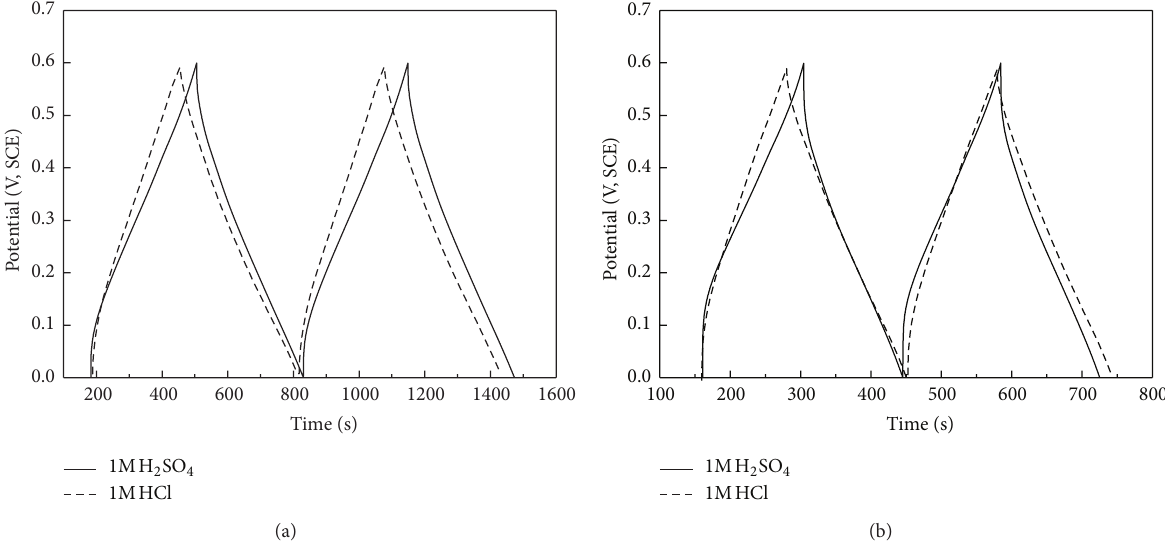
Figure 4: Charge/discharge curves of PANI in different acid electrolytes at the same current density ((a) 0.5 Ag −1 , (b) 1Ag −1 ).